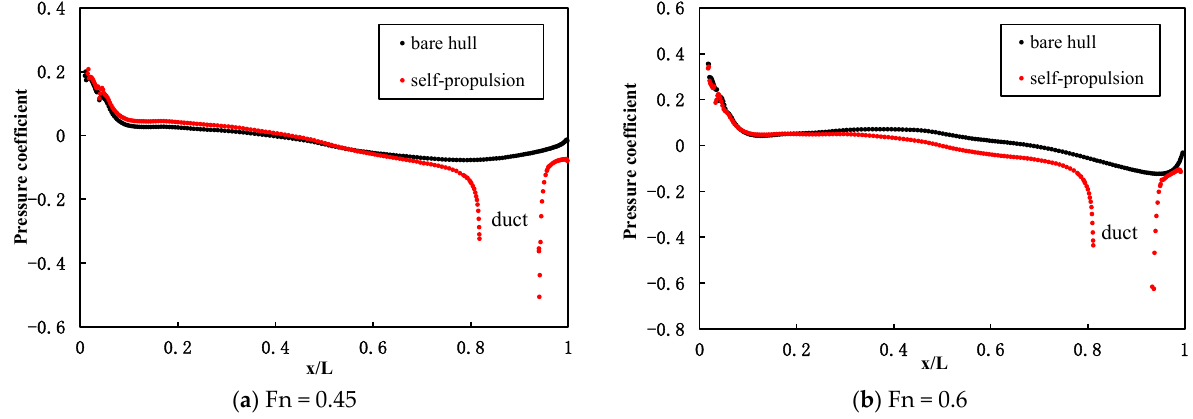
Figure 17. Comparison of the pressure coefficient on the center plane of hull bottom.